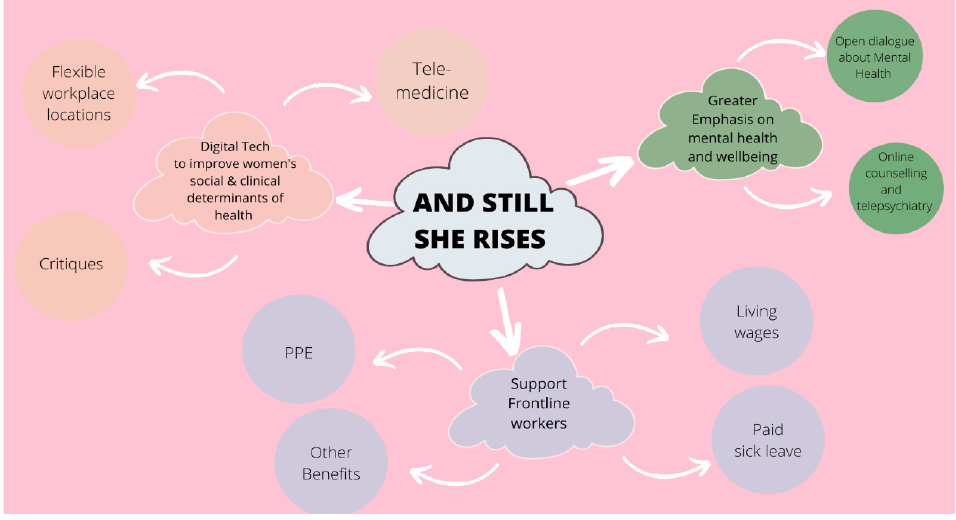
Figure 1. The focus group themes across geographic regions (Diagram by Sheyn Hosanee).